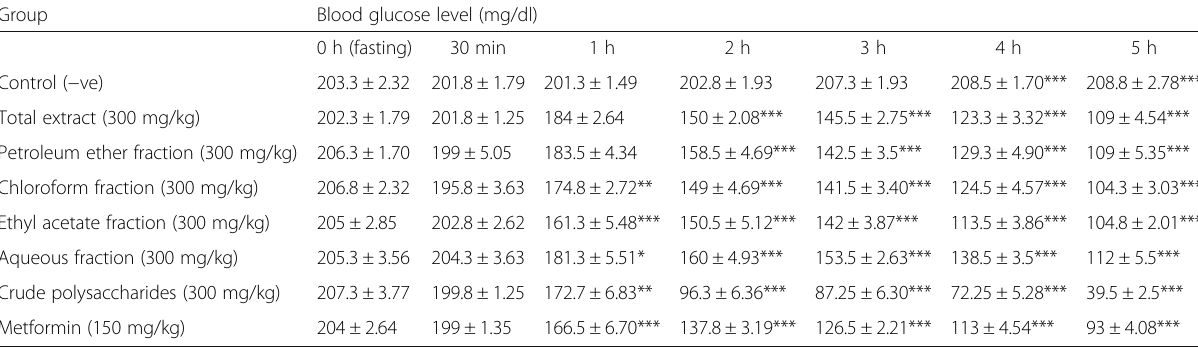
Table 6 Results of anti-diabetic activity of the total ethanolic extract and different fractions of A. hirtum leaves on streptozotocin-induced